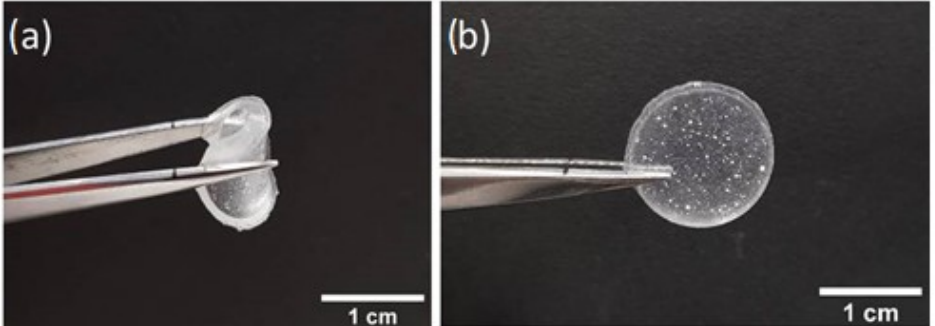
Figure 8. Flexible film ( a ) folded and ( b ) unfolded .